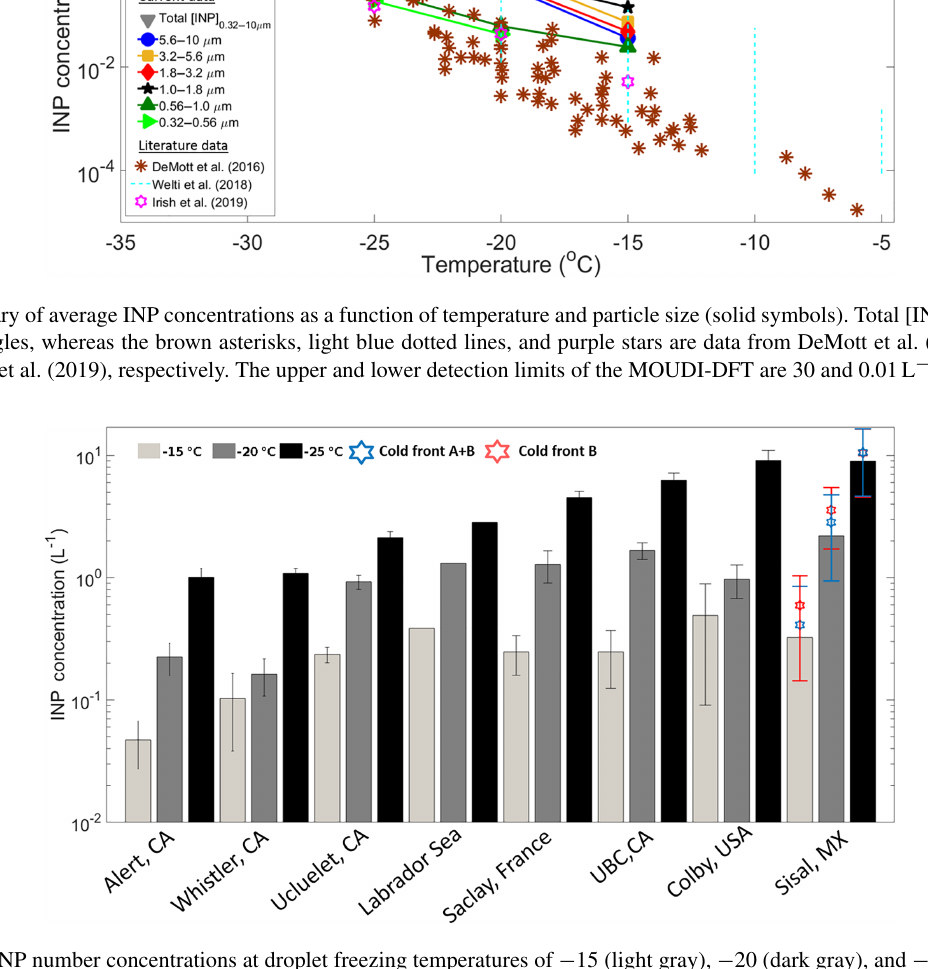
Figure 5. Mean INP number concentrations at droplet freezing temperatures of − 15 (light gray), − 20 (dark gray), and − 25 ◦ C (black). The blue and red stars represent the mean INP concentration during the cold fronts A and B and cold front B, respectively. Uncertainties are given as the standard uncertainty of the mean (adapted from Mason et al.,